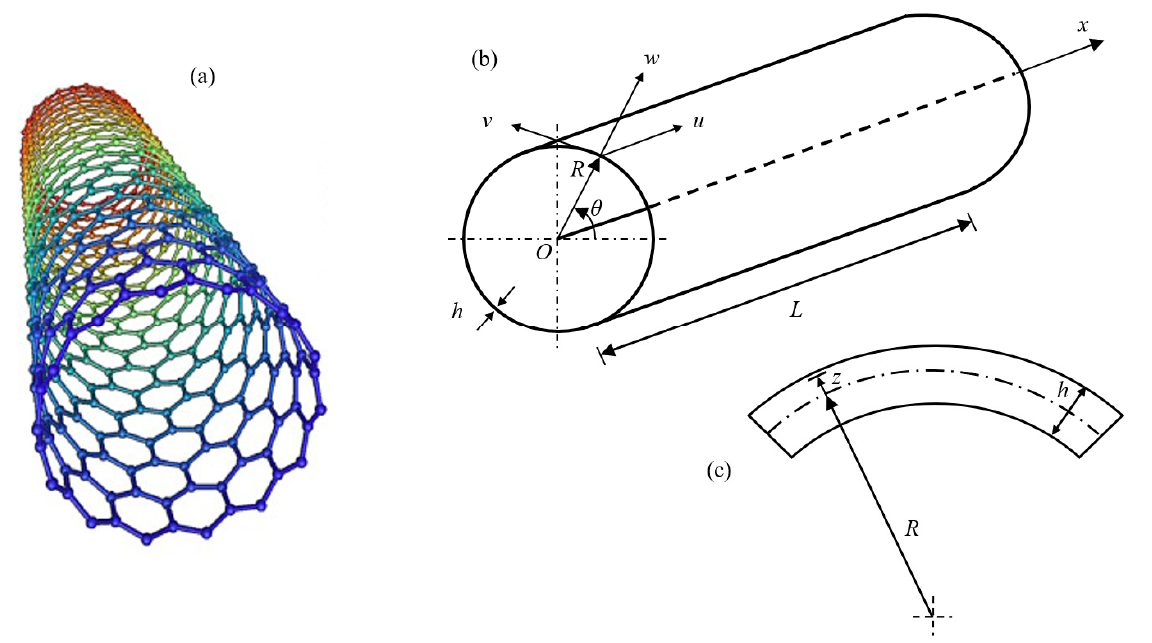
Figure 1. Continuous modelling of SWCNTs: ( a ) actual discrete SWCNT; ( b ) geometry of the equivalent continuous circular cylindrical shell; and ( c ) cross-section of the surface of the equivalent continuous circular cylindrical shell [20].